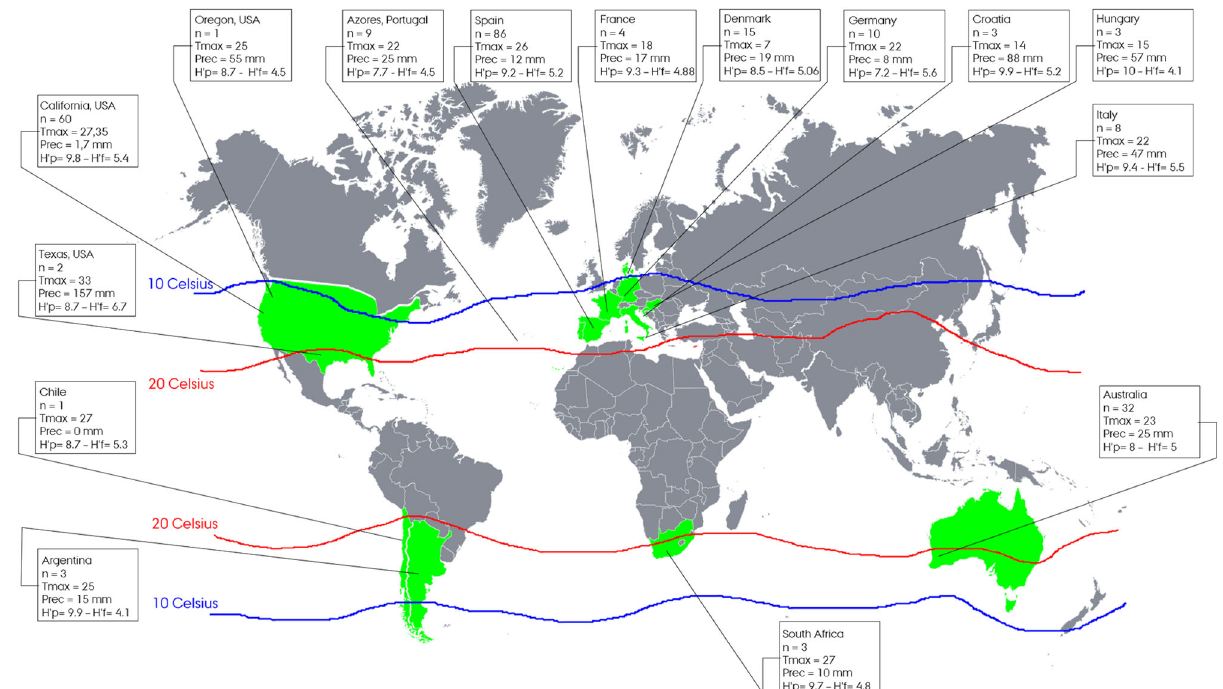
Fig. 1 Coverage of the study. The countries highlighted in green are represented in the study ’ s dataset. The two isothermal lines de fi ne the range for optimal conditions for grapevine cultivation (isothermal source: https://www.thirty fi fty.co.uk/spotlight-climate-change.asp). Each panel shows the country, the number of samples ( n ) and information about the average maximum temperature (Tmax) and the level of precipitation (Prec) up to 2 weeks before sample collection. Finally, H ′ P and H ′ F de fi ne the Shannon Index for the prokaryotic and fungal community